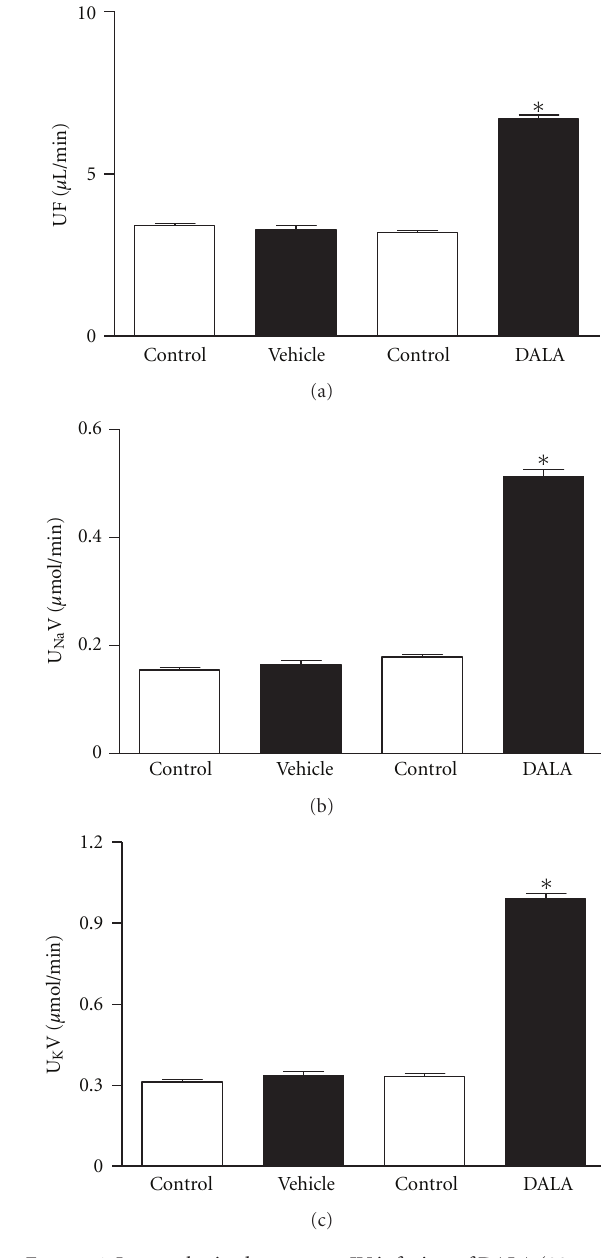
Figure 4: In anesthetized rats, acute IV infusion of DALA (80 μ mol/ kg) increased urine flow, urinary sodium, and urinary potassium excretion in L-NAME-pretreated animals. Values are mean ± SE; n = 20. ∗ P < 0 . 05 versus control (vehicle